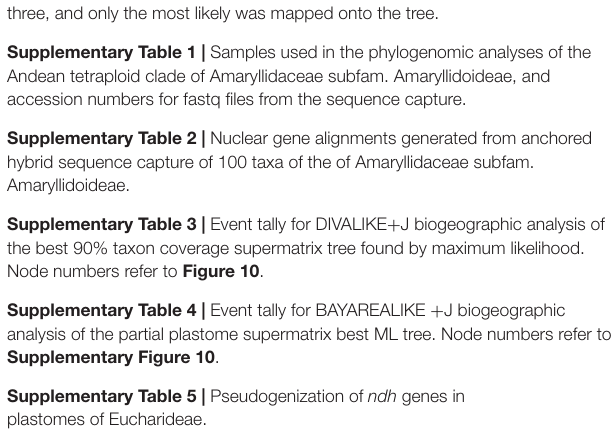
Supplementary Figure 8 | Results of the densiTree comparison of relaxed and correlated penalized likelihood age-calibration of the best maximum likelihood tree found by RAxML using the 90% taxon coverage supermatrix and a range of values for λ (0–5). Supplementary Figure 9 | Area cladogram generated by Bayarealike + J analysis with BioGeoBears through RASP 4.2, using the best maximum likelihood tree found for the partial plastome supermatrix. Areas at any node were limited to three, and only the most likely was mapped onto the tree. Supplementary Table 1 | Samples used in the phylogenomic analyses of the Andean tetraploid clade of Amaryllidaceae subfam. Amaryllidoideae, and accession numbers for fastq files from the sequence capture.